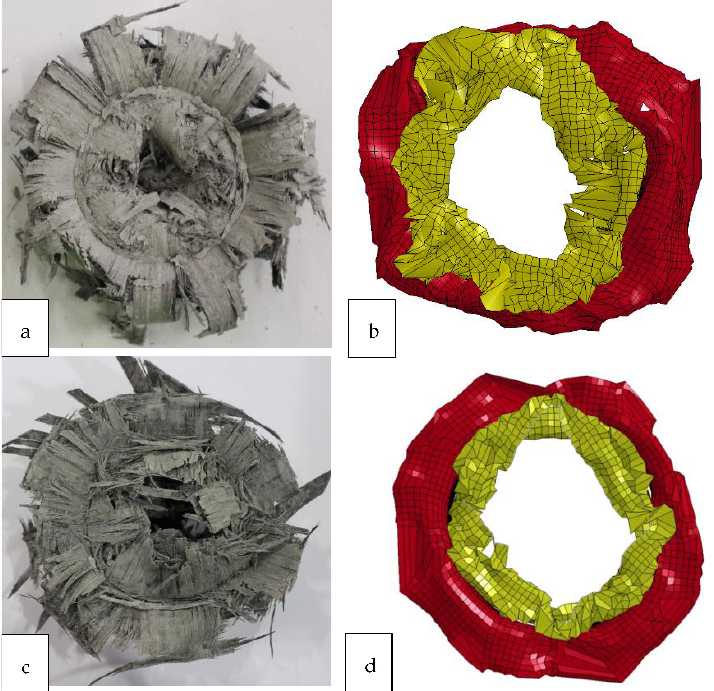
Figure 27. Plane view morphologies, experimental and numerical comparison, ( a ) crushed under quasi-static experimental, ( b ) crushed under quasi-static numerical, ( c ) crushed under impact loading experimental, ( d ) crushed under impact loading numerical [63,65].